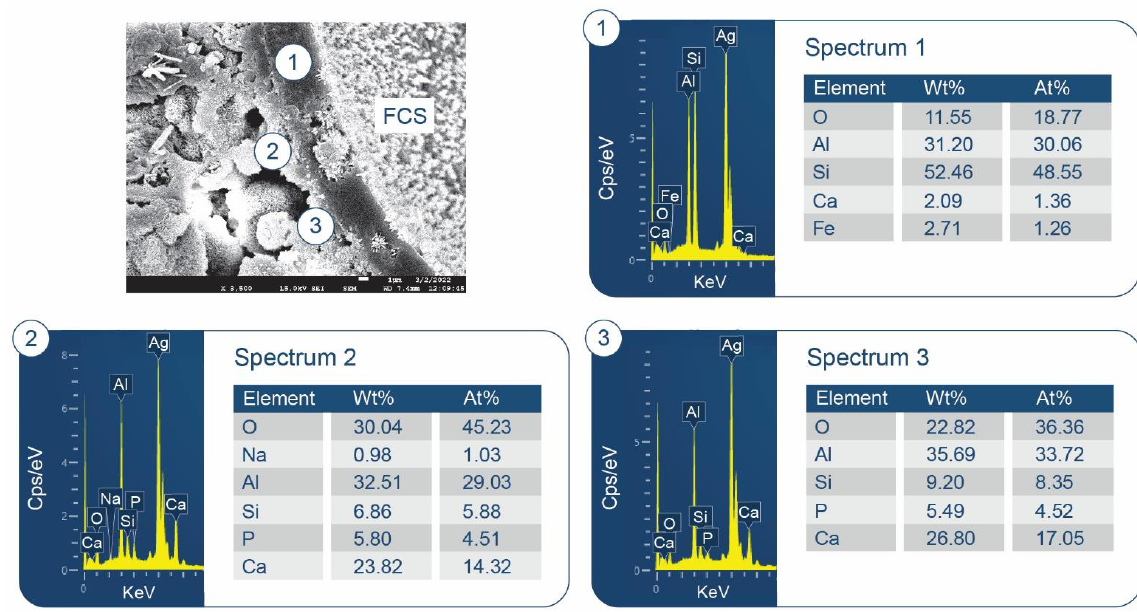
Figure 13. Morphology and elemental composition at the interface between cement and FCS surface of CaP/FCS cement cured at 250 °C.